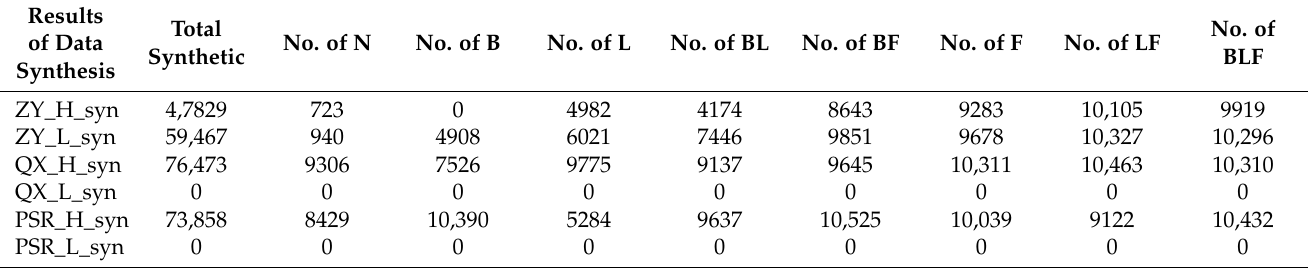
Table 4. Synthesis results of basic training dataset by high and low